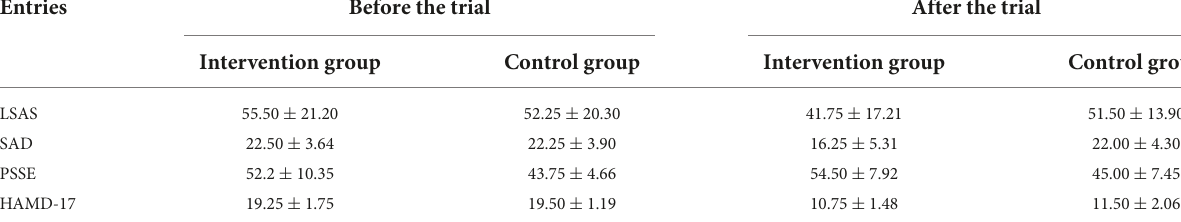
TABLE 3 The grading of the pre-experiment (n1 = n2 = 6; LASA, Liebowitz social anxiety scale; SAD, social avoidance and distress scale; PSSE, scale of perceived social self-efficacy; HAMD-17, Hamilton depression